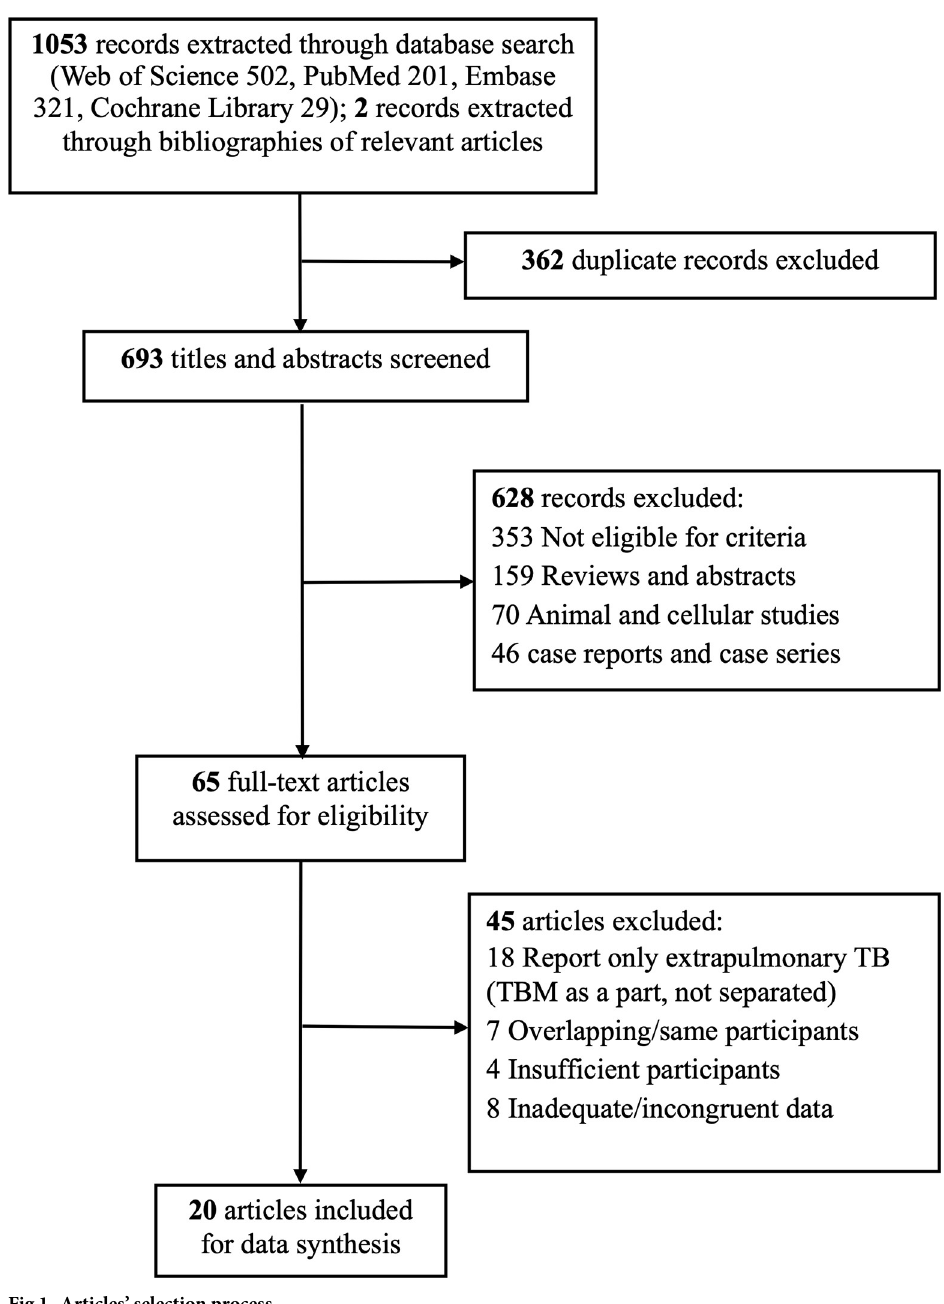
Fig 1. Articles’ selection